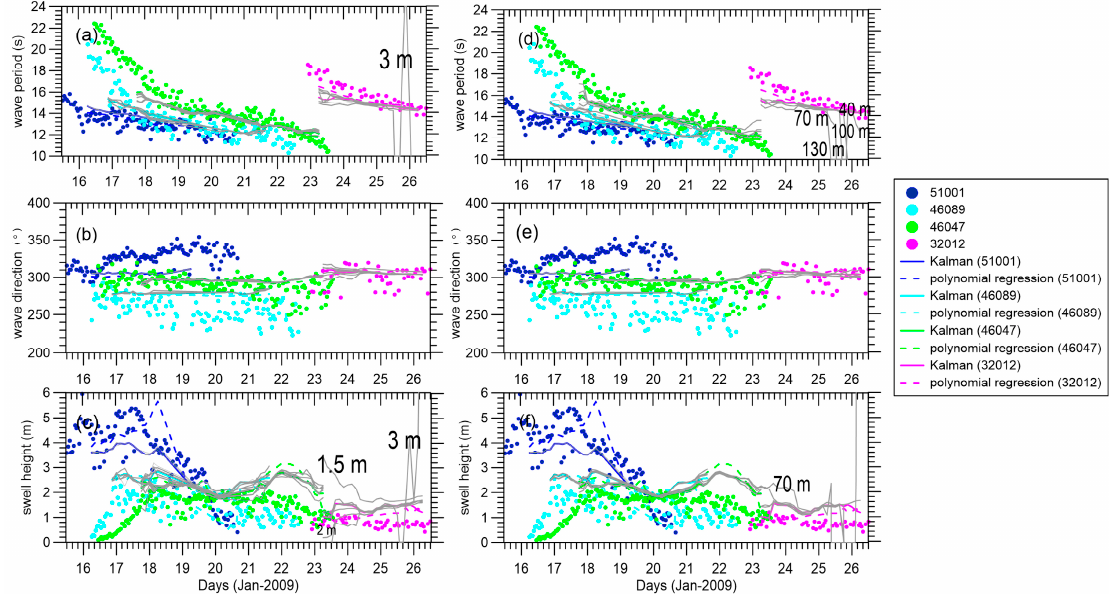
Figure 8. ( a – c ) Gray lines are EnKF results with the swell height model error changing as follows: 0.1, 0.3, 0.7, 1, 1.5, 2, and 3 m; ( d – f ) Gray lines are EnKF results with the wavelength model error changing as follows: 20, 40, 70, 100, and 130 m at buoys 51001, 46089, 46047, 46086, and 32012, respectively. The